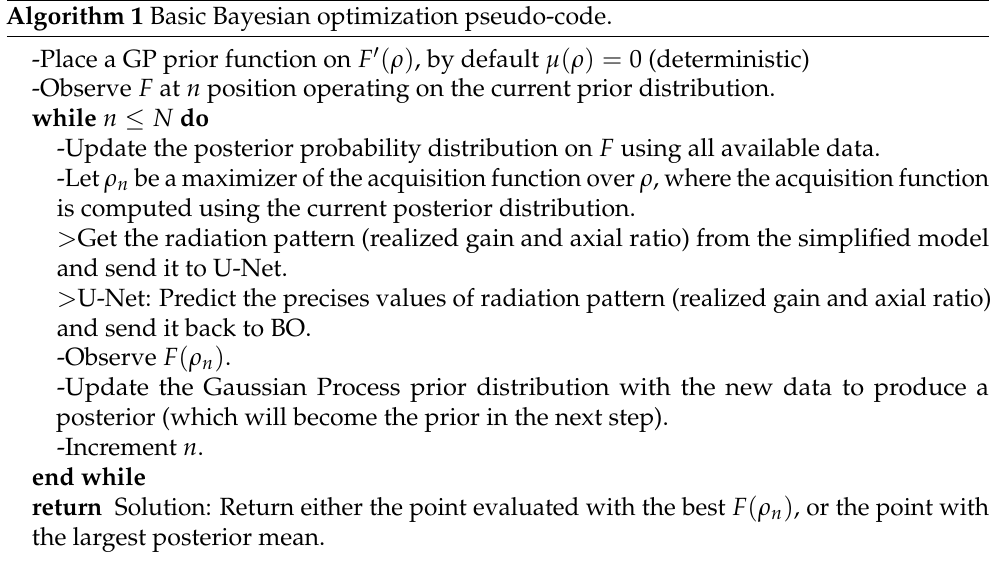
Algorithm 1 Basic Bayesian optimization